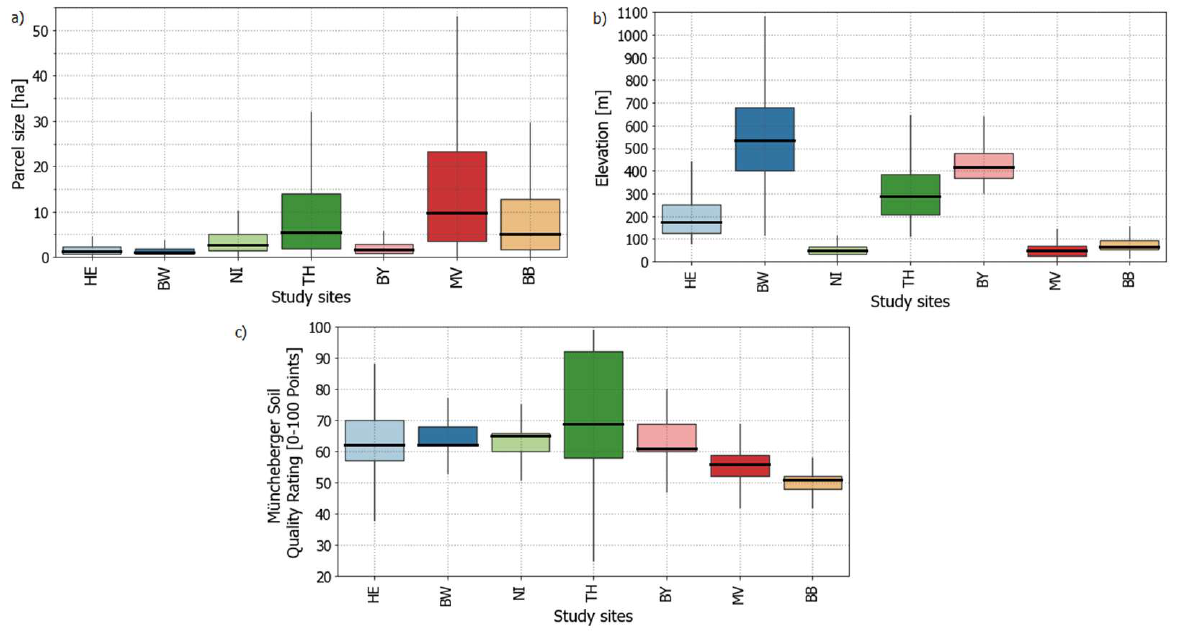
Figure 12. Distribution of ( a ) parcel sizes, ( b ) surface elevation, and ( c ) Müncheberger soil quality values among the seven study sites. Each boxplot contains all sampled 5500 points.